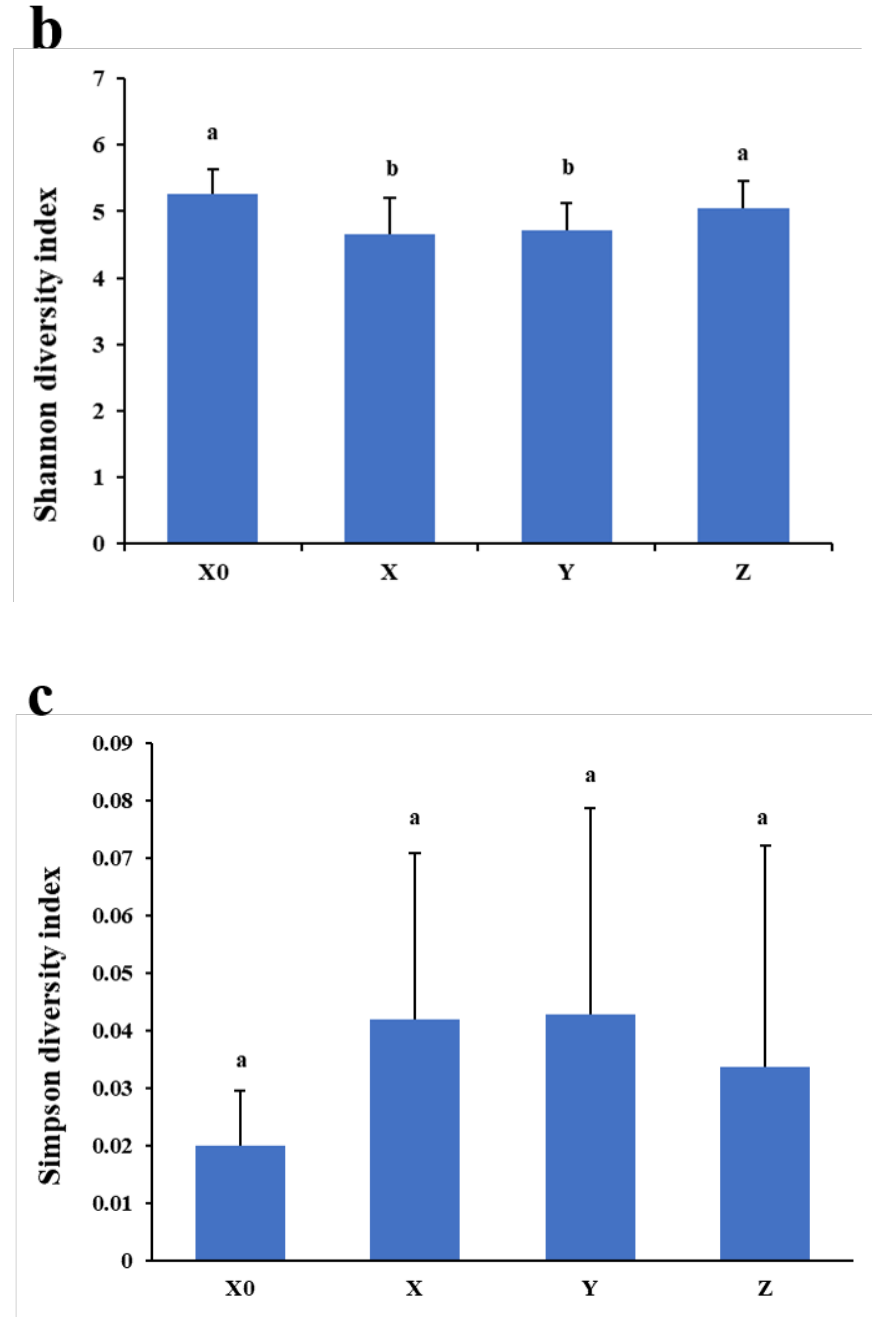
Figure 2. ( a ) Chao 1 richness index of samples from four different periods. ( b ) Shannon diversity index of samples from four different periods. ( c ) Simpson diversity index of samples from four different periods. Different lowercase letters within each sampling group represent significantly different means ( p < 0.05). X0, X, Y, and Z indicate the periods Day 0, medication, withdrawal, and recovery, respectively.